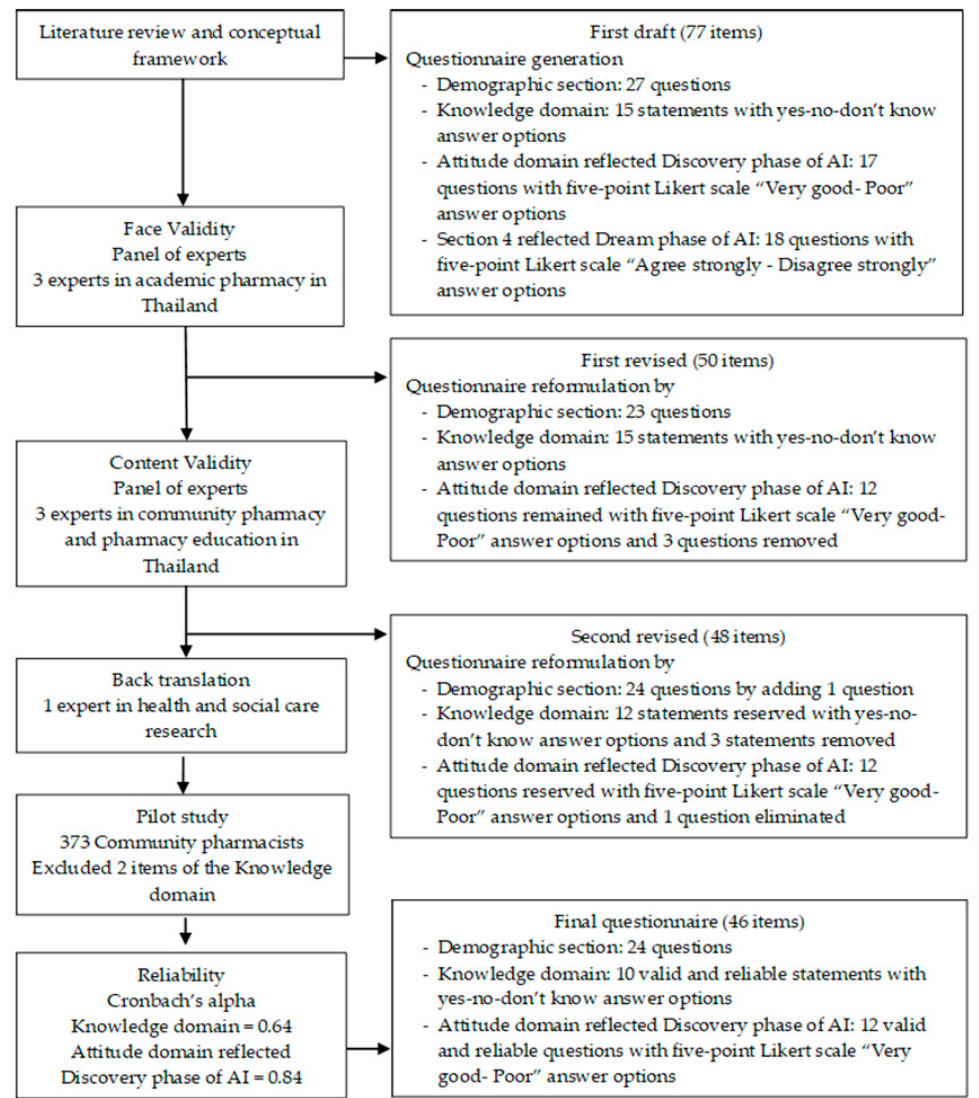
Figure 1. Flow Chart of the Development and Validation of the Novel Survey Tool.